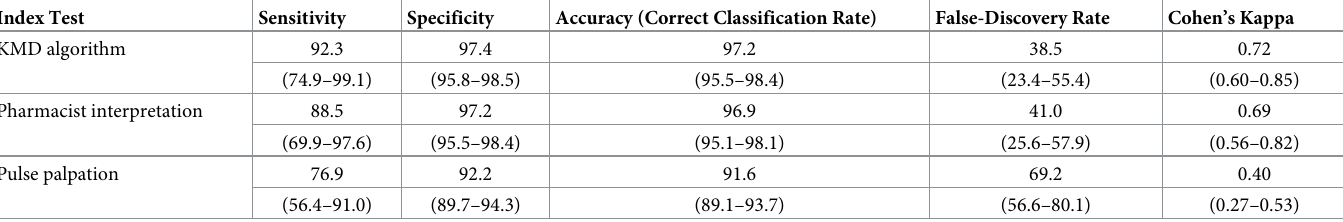
Table 2. A summary of diagnostic accuracy. Interpretation of SL ECG by the KMD algorithm, pharmacist interpretation, and pulse palpation when compared with the cardiologist interpretation (expressed as a mean (95%